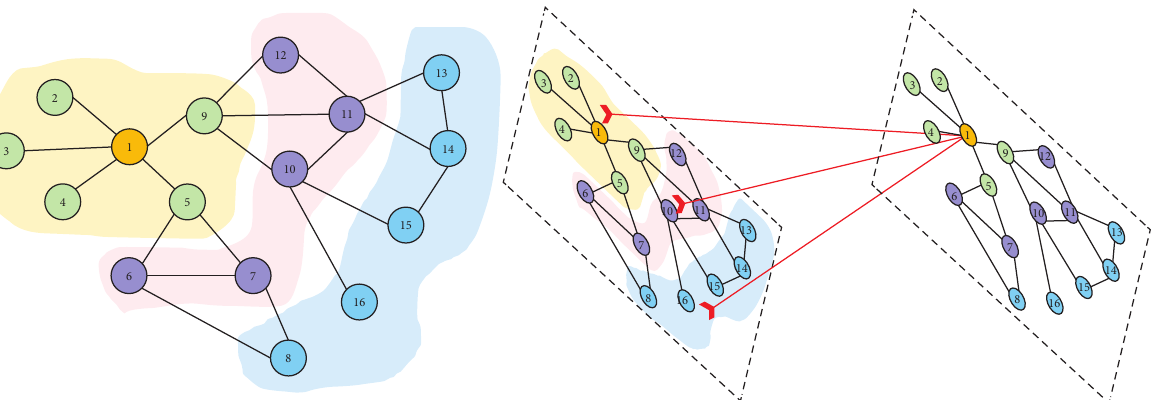
Figure 1: K-hop neighbors of graph convolution.